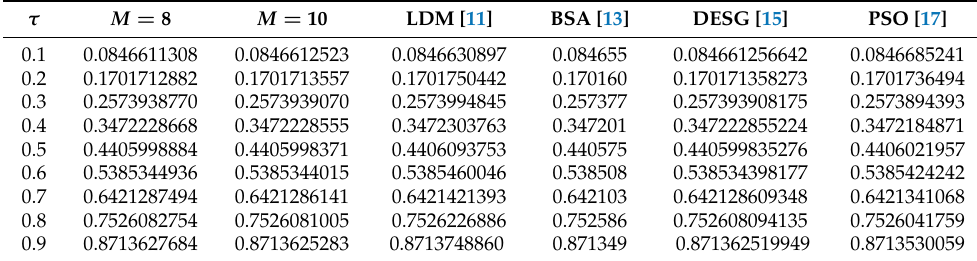
Table 2. Comparison of numerical solutions in QLM-Bessel for Test case 2 using M = 8,10 and [ 0,1 ] . various τ ∈